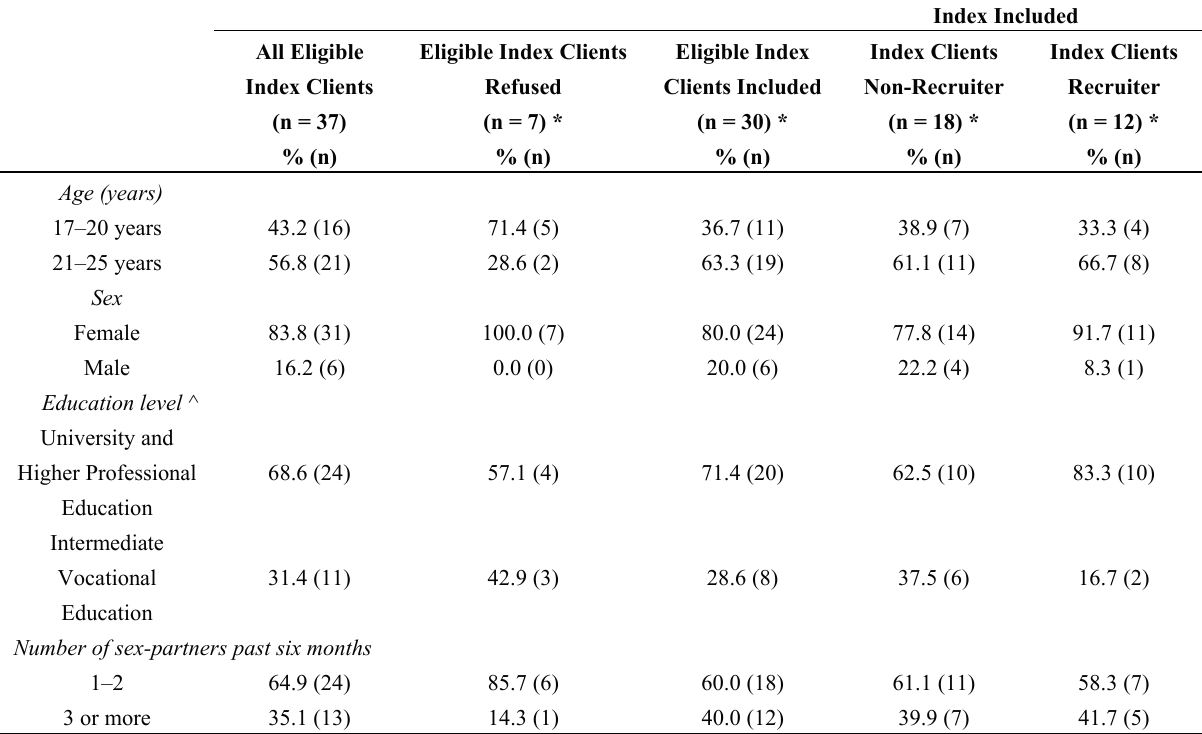
Table 1. Characteristics of index clients who recruited peers and